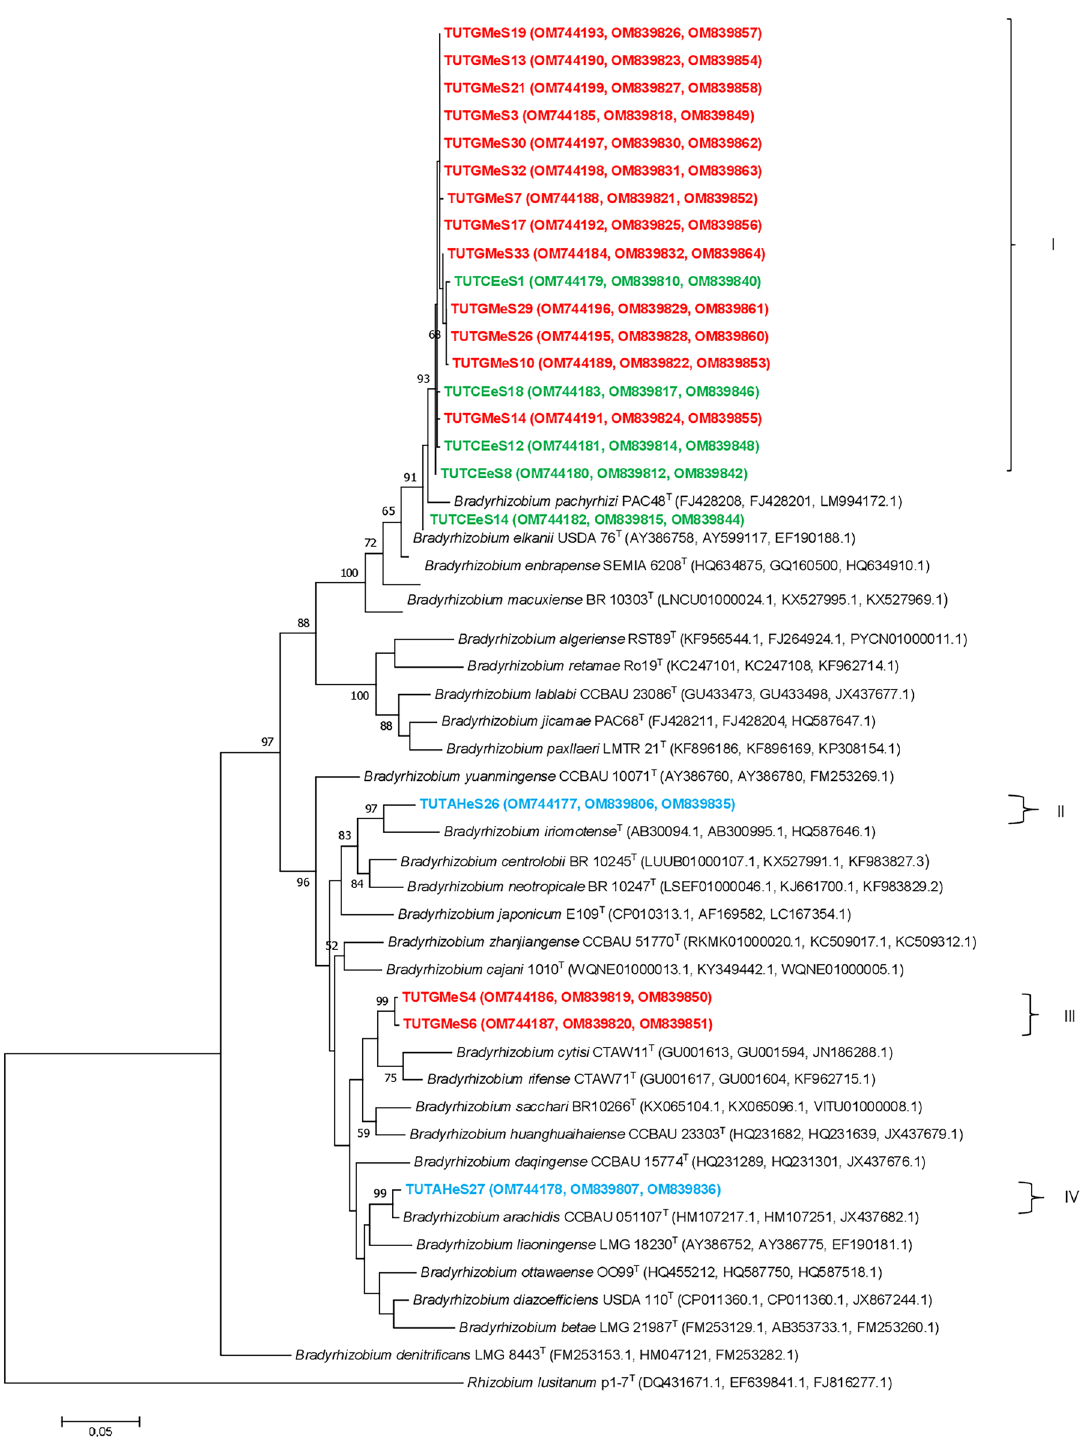
Figure 4. Maximum likelihood phylogenetic tree based on the concatenated atpD-glnII-rpoB gene sequences of groundnut, jack bean and soybean isolates from various locations in Eswatini. In each isolate the location is indicated by assigning different symbols, e.g., circle-Malkerns Research station; square-New Heaven and triangle-Luve. Isolates’ names are colour coded based on the host species as Blue-groundnut, Green-jack bean and